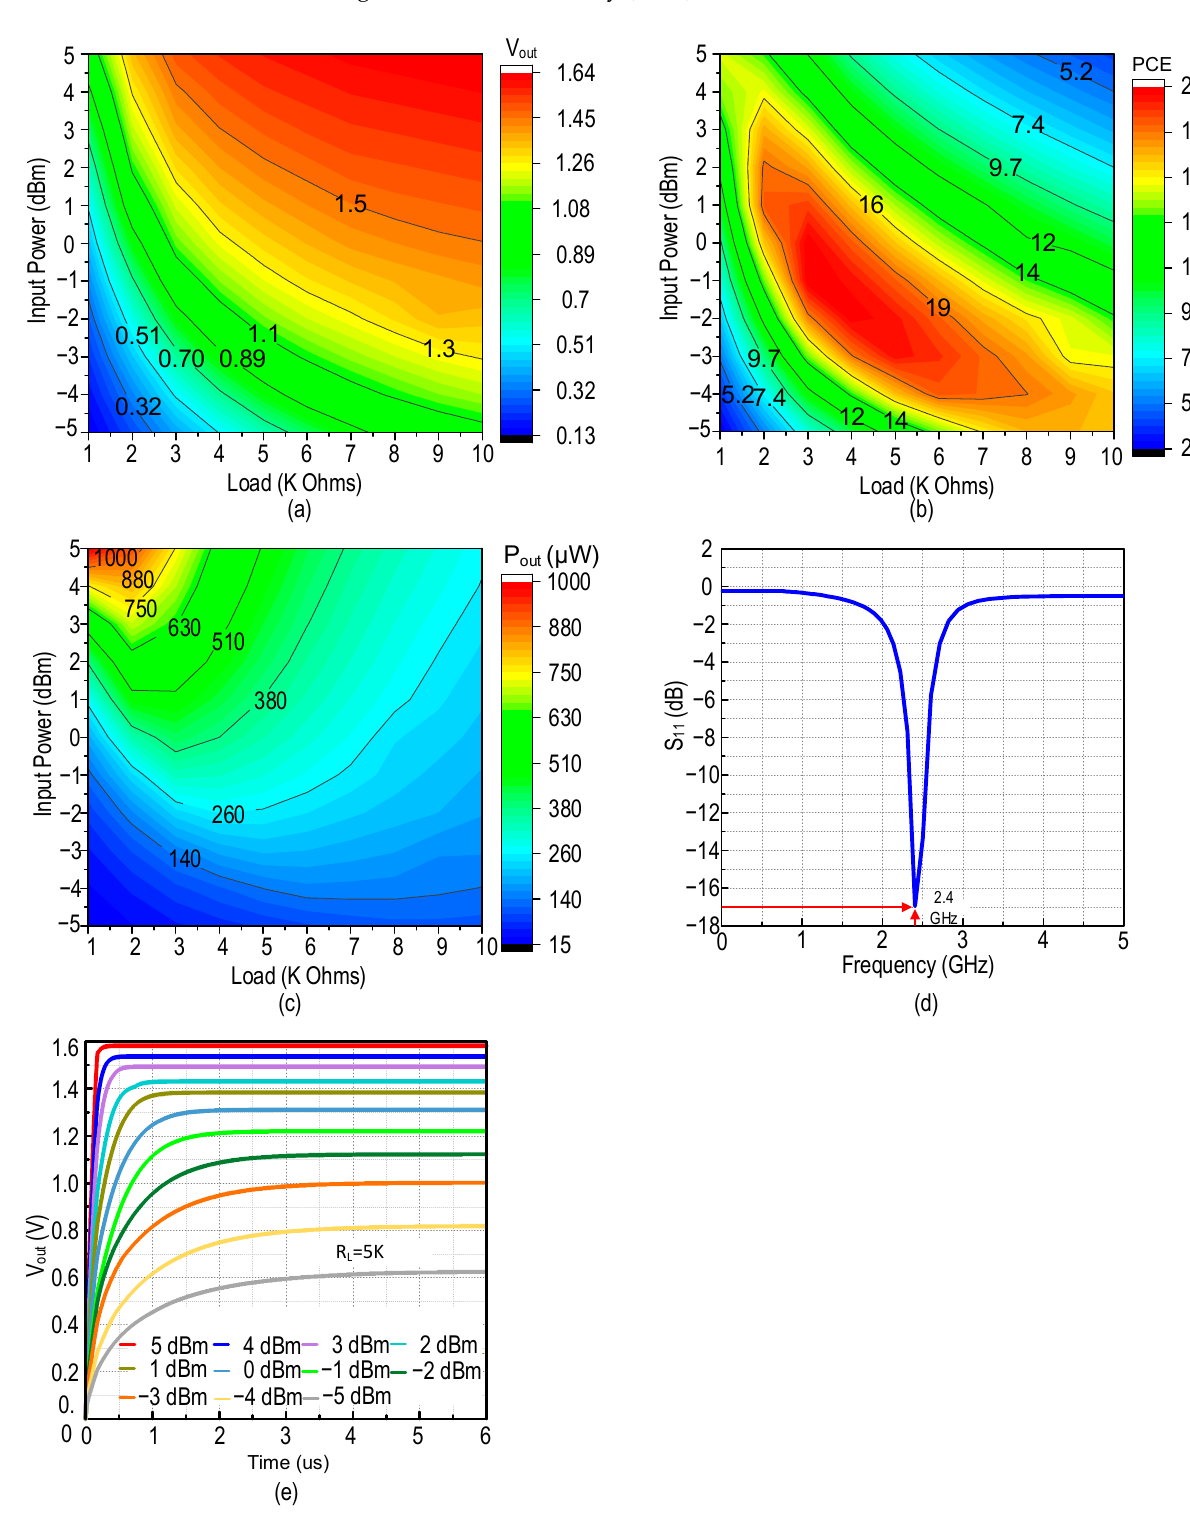
Figure 13. Post-layout Simulation results of RFEH: ( a ) V out , ( b ) PCE, ( c ) P out , ( d ) reflection coefficient (|S 11 |) versus frequency, and ( e ) transient response.